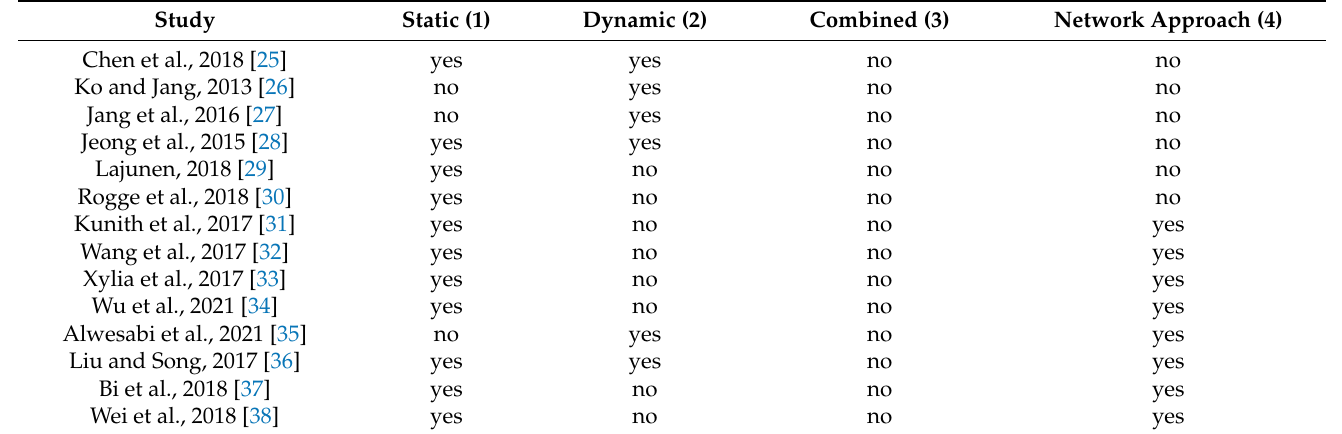
Table 1. Approaches of corresponding